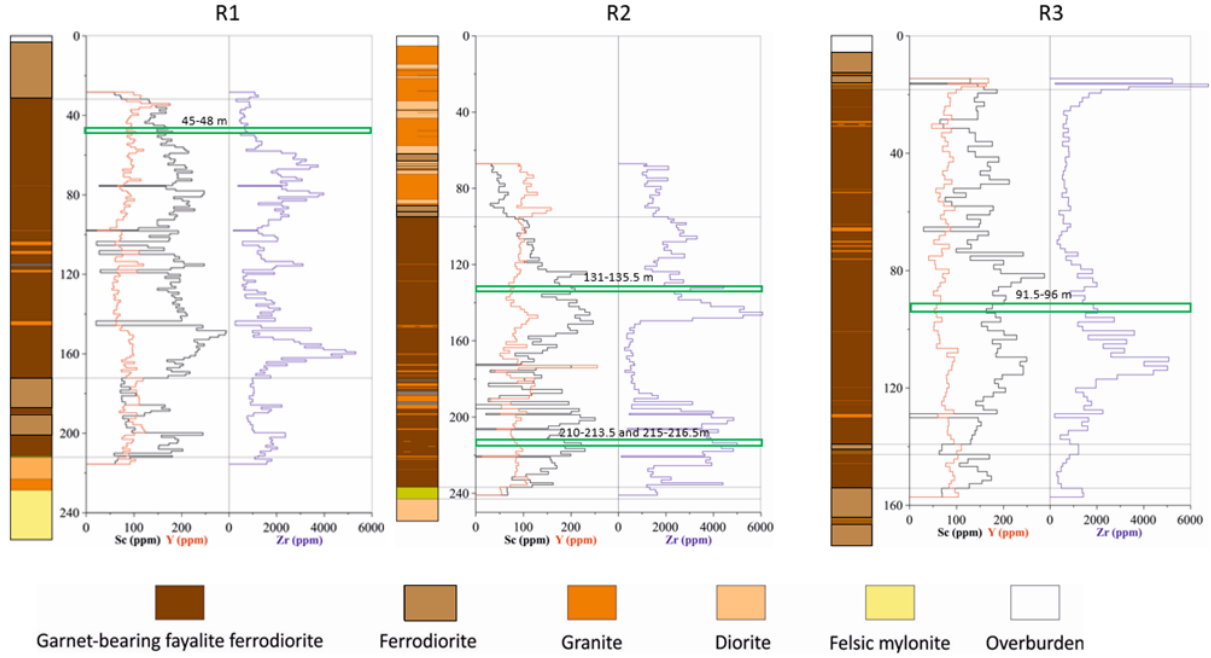
Figure 3. Lithological columns and variations of Sc, Y and Zr concentrations in drill holes R1, R2 and R3, with the locations of the selected samples indicated with green rectangles (modified from [28], printed with the permission from GTK). Note the different scale (in meters) for each column.